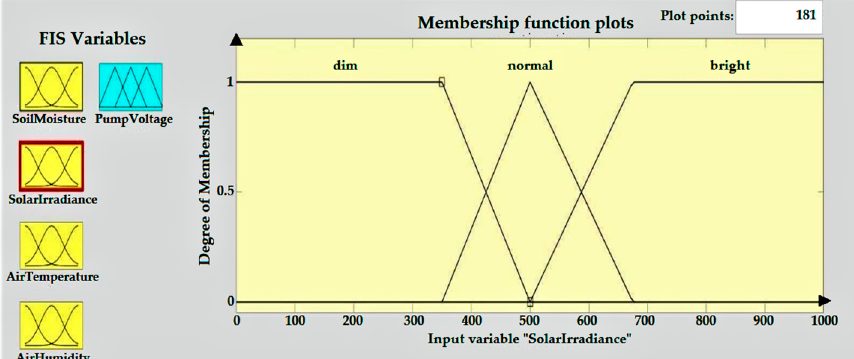
Figure 4. Solar irradiance membership function plot.